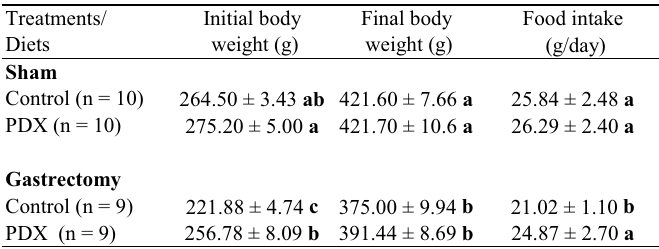
TABLE 2 - Initial and final body weights and food intake of sham- operated and rats with gastrectomy fed diets with polydextrose (PDX) or without polydextrose (control)